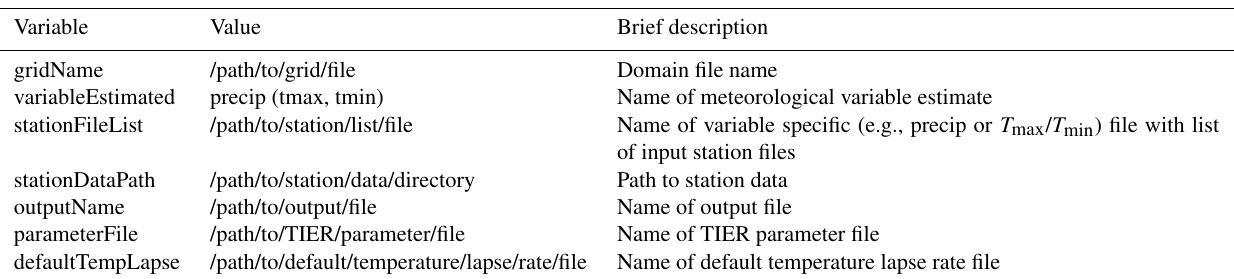
Table 4. TIER model control